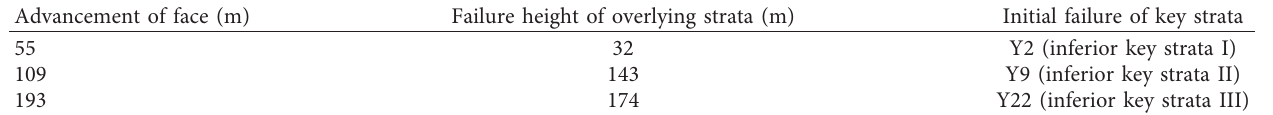
Table 3: Initial failure of each key strata with advancement of the working